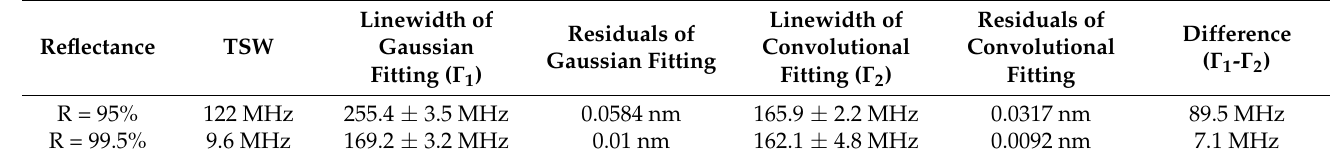
Figure 6. ( a ) Convolutional fitting—Gaussian fitting (R = 95%) and ( b ) Convolutional fitting— Gaussian fitting (R = 99.5%). Table 1. Comparison of error reduction using etalon with different reflectance.